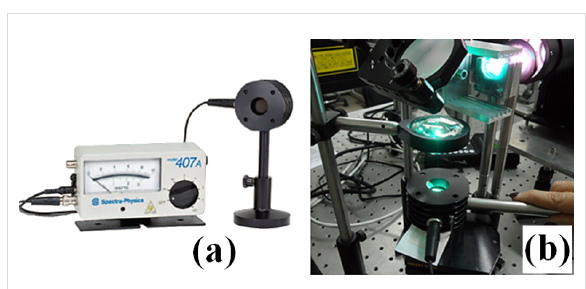
were performed varying the weight ratio of MWCNT/ferrocene from 4:1 to 1:4, using the whole lamp emission spectrum (Figure 9) and making use of the optical attenuation ND filters (for adjusting to the beam power level that reaches the sample).